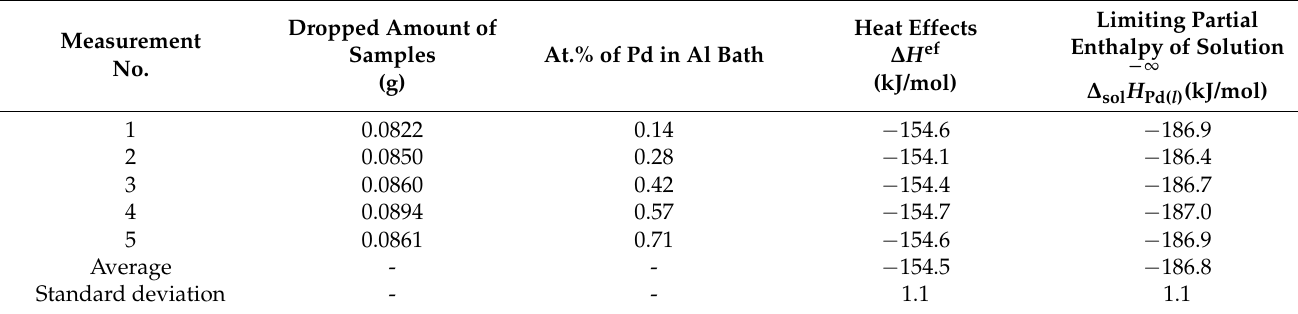
Table 4. Values of the limiting partial enthalpy of the solution of liquid Pd ∆ sol H pressure p = 0.1 MPa; a calibration constant K = 0.000003207 kJ/ µ Vs; enthalpy of the pure Pd ∆ H T 298 → T 1033 temperature of the Al bath T M = 1033 K; and drop temperature T D = 298 K.